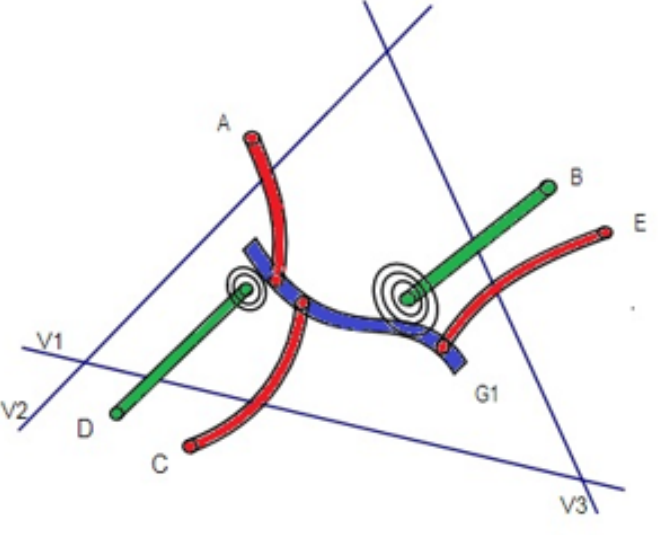
Figure 10. A set of nonlinear constraints in combination with the proposed three groups of logically- based